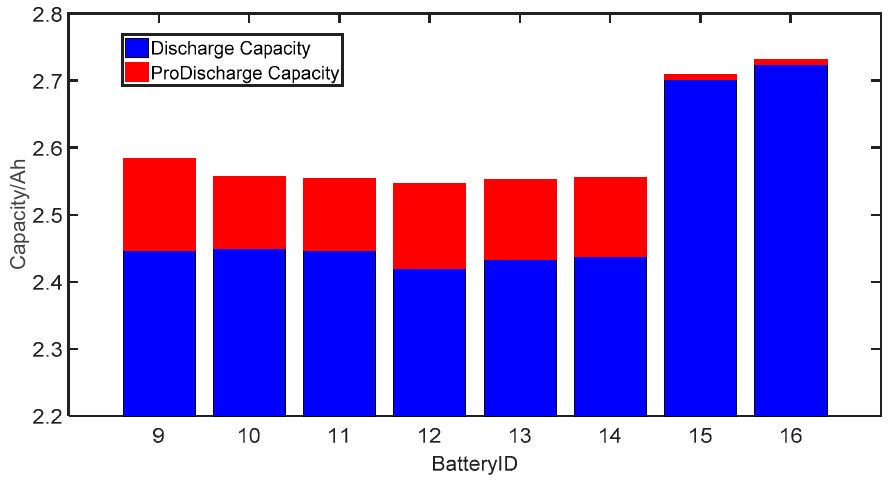
Figure 8. The comparison of discharge capacity and pro-discharge capacity.